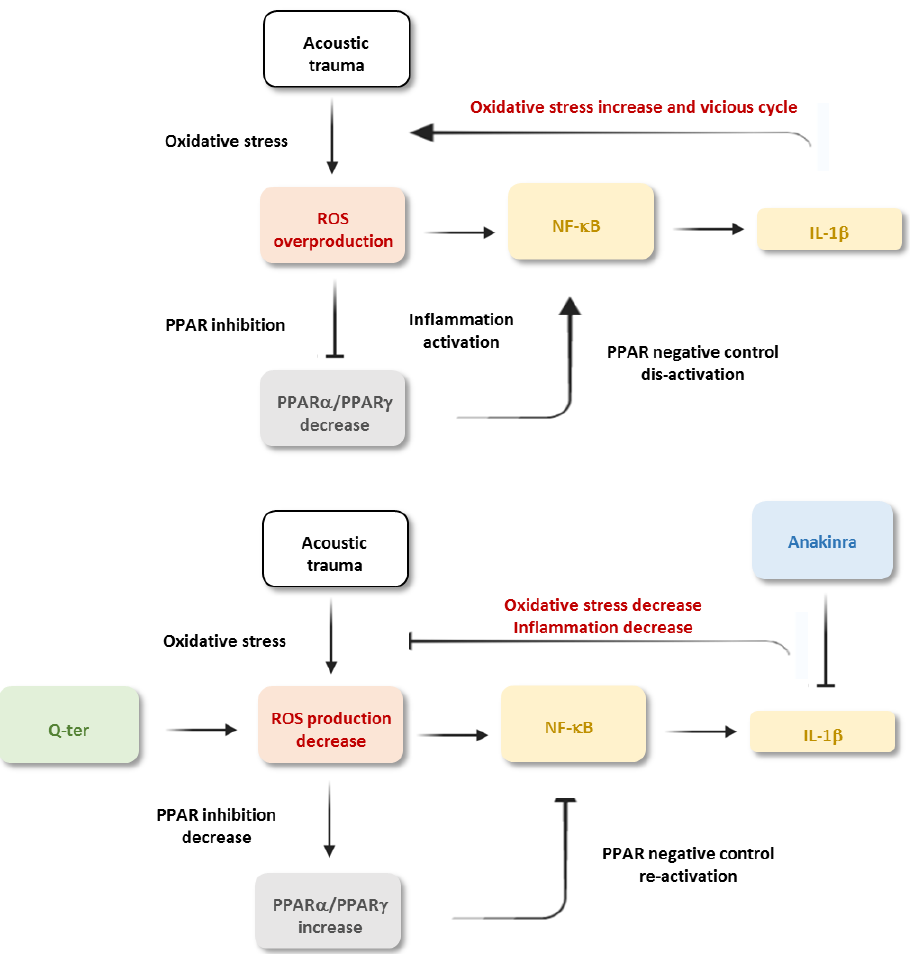
Figure 8. Suggested mechanisms of damage in noise-induced cochlear injury. Acoustic trauma induces an increase in ROS amount in the cochlea, leading to oxidative stress and inflammation. Noise-induce metabolic damage can affect PPAR cochlear expression, leading to a down-regulation of PPAR receptors that, in turn, is responsible for the dis-activation of the negative control on inflammatory signaling. Indeed, this could lead to an increase in inflammatory markers, pro-inflammatory cytokines (IL-1 β ) and NF- κ B. Given the interplay between oxidative stress and inflammation, the rise in inflammatory markers could exacerbate oxidative stress, causing a damaging vicious cycle among oxidative stress, PPAR down-regulation and inflammation. An antioxidant treatment with Q-ter can stop the feedback loop by blocking oxidative stress, the key damaging player in cochlear injury induced by noise. In our hypothesis, decreased ROS production consequently could decrease PPAR inhibition inducing PPAR negative control re-activation on inflammatory markers. An anti-inflammatory treatment (Anakinra) shows less protective effects.